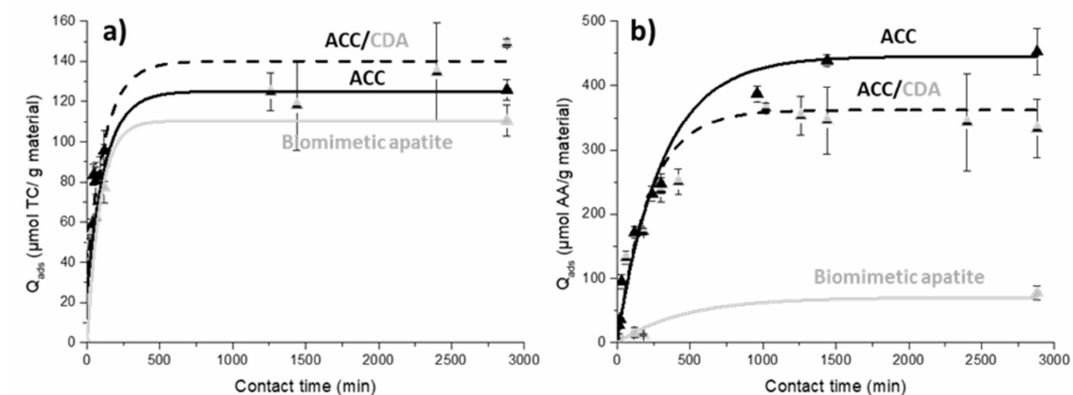
Figure 5. Adsorption kinetics at pH = 7.4 and room temperature on biomimetic apatite (grey line), ACC (black line) and ACC/CDA material (black dash line) for ( a ) tetracycline and ( b )